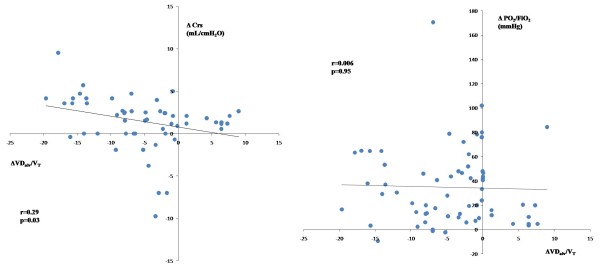
Correlation between changes in alveolar dead space (ΔVDalv/VT) and changes in compliance of the respiratory system (ΔCrs, left) or in PaO2/FiO2 (ΔPaO2/FiO2, right) at each time of the study when compared with the supine position.